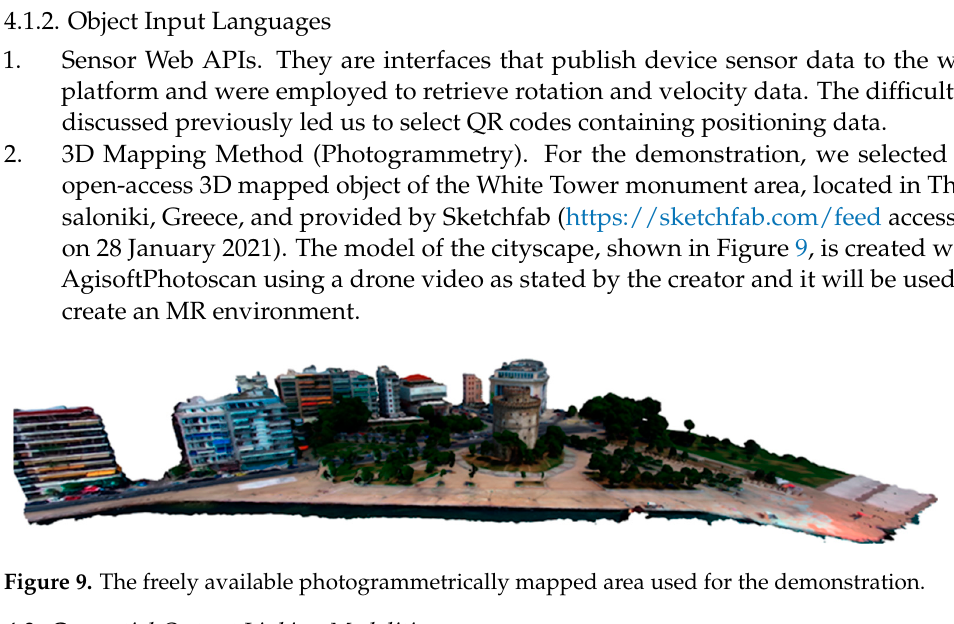
Figure 9. The freely available photogrammetrically mapped area used for the demonstration.